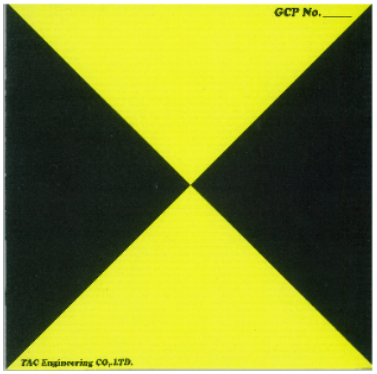
Figure 4. Georeference marker.